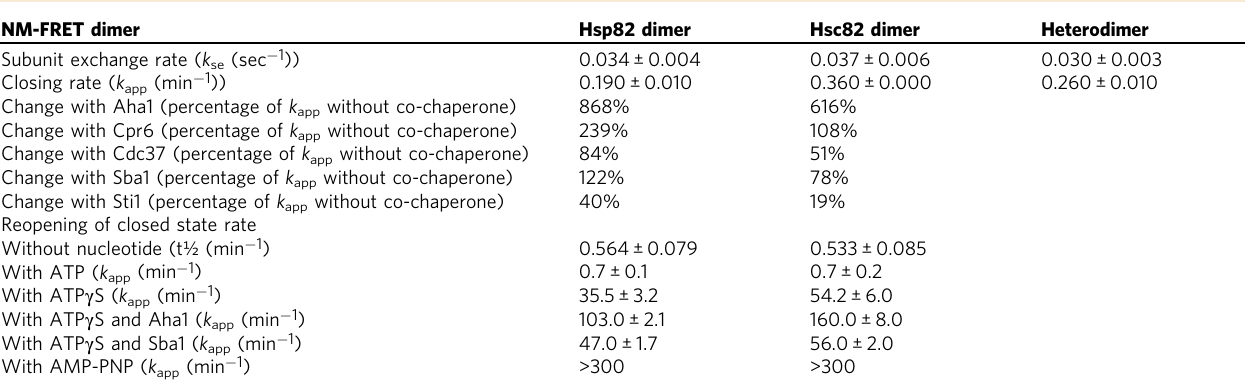
FRETbetweentheNTDofoneprotomerandtheMDoftheotherprotomers(NM-FRET)wasrecordedwithprotomersthathad fl uorescentdyesattachedatC61orC385(Hsp82)orC381(Hsc82).FRET in the absence of nucleotides was used to obtain subunit exchange rates (k se ) between protomers 4 . FRET in the presence of ATP γ S (which stabilizes the closed state) was used to monitor the closing kinetics 4 . FRET chase experiments, which report on the stability of the closed complex, were performed by addition of an excess of unlabeled Hsp90 to a preformed Hsp90 FRET complex (preformed with ATP γ S or AMP-PNP) 4